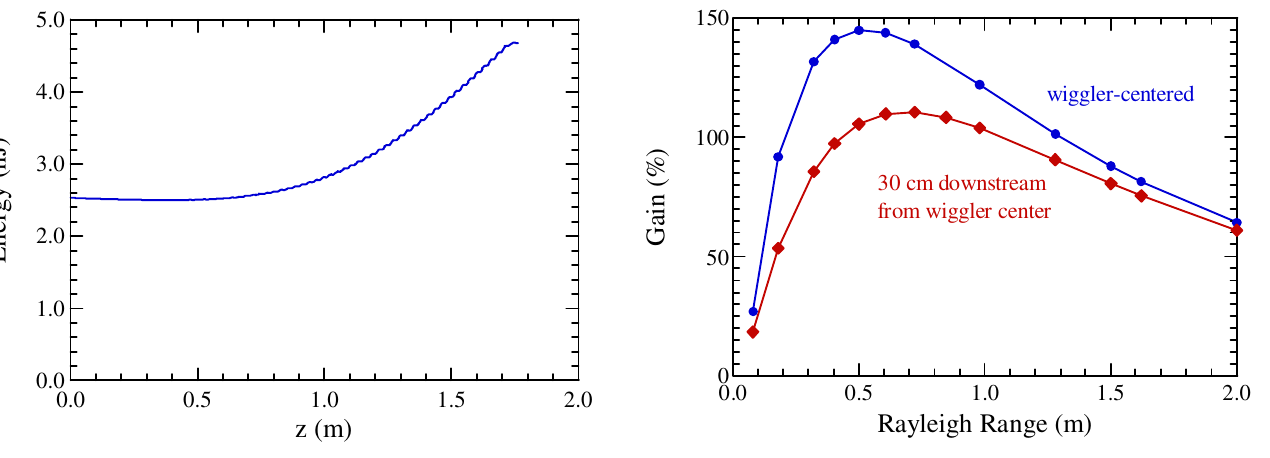
FIG. 5. (Color) Plot of the amplification of the total pulse energy through the